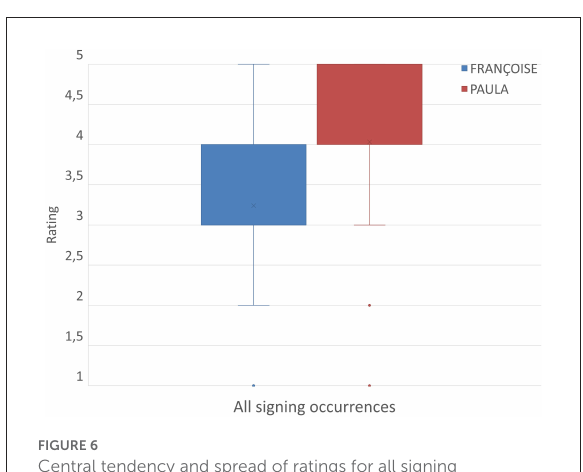
FIGURE6 Central tendency and spread of ratings for all signing occurrences for both